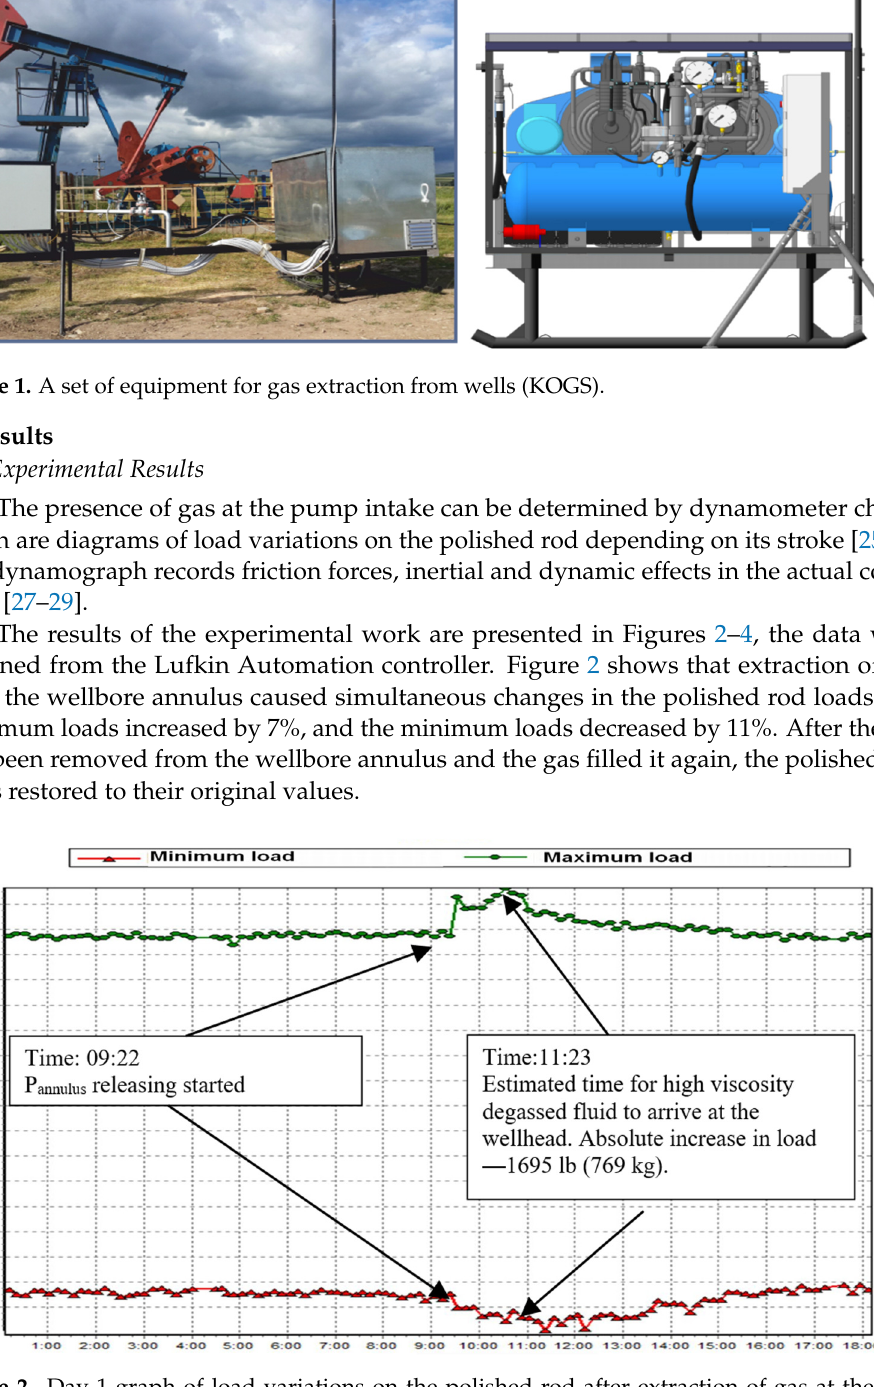
Figure 2. Day 1 graph of load variations on the polished rod after extraction of gas at the well No.14764d.